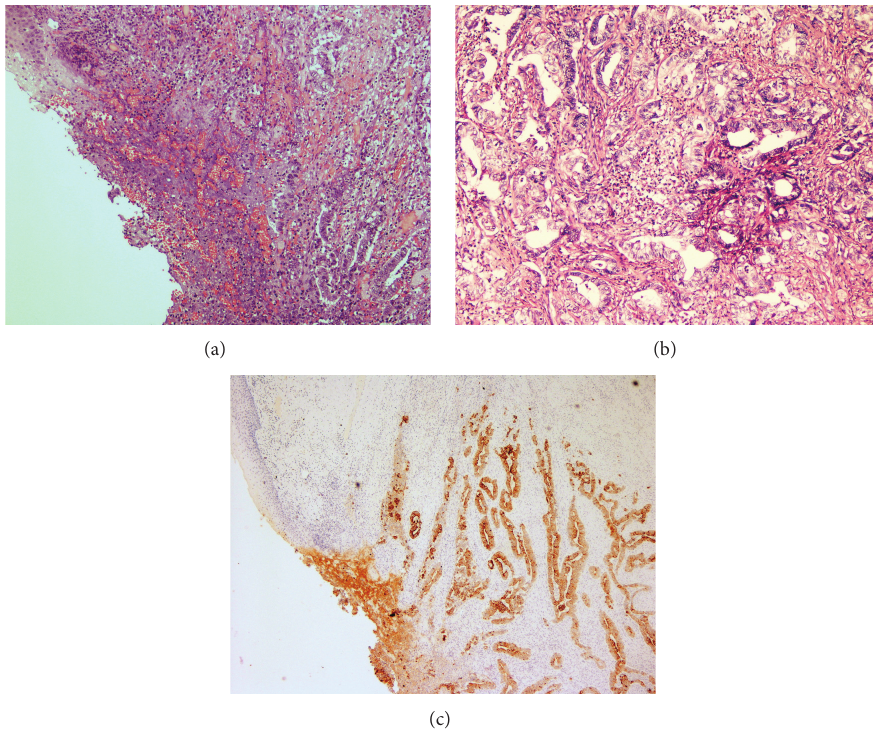
Figure 2: (a) Ulcerated lesion of the uterine cervix: the bottom of the ulcer shows an adenocarcinomatous proliferation. Haematoxylin-eosin, 100x. (b) Higher magnification of the malignancy, showing a moderately differentiated adenocarcinoma (G2). (c) Immunohistochemical expression of cytokeratin 20 in the neoplastic